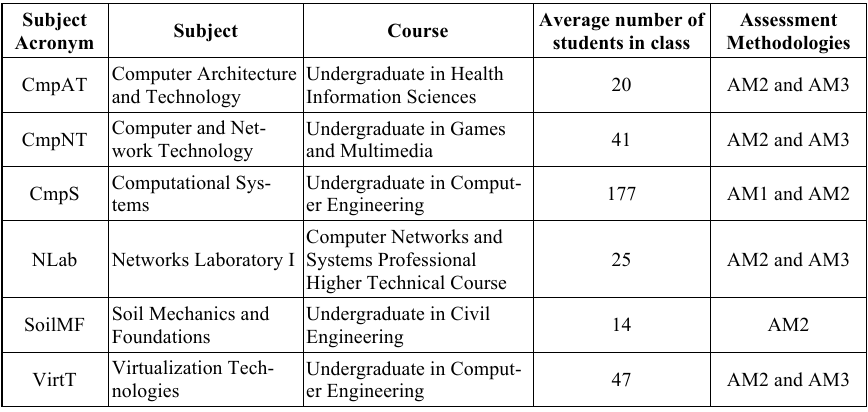
Table 1. Overview of the case